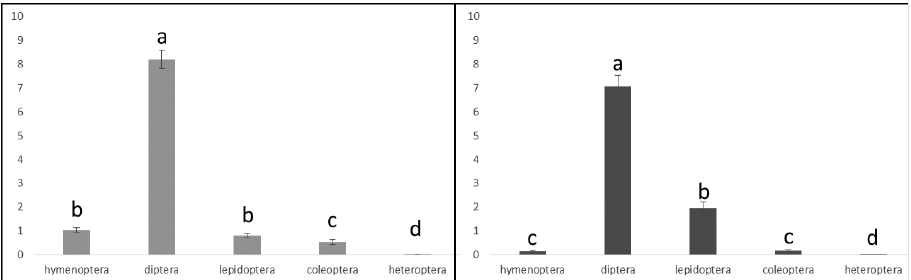
Figure 2. Average number of insects per urns in 2015 (light grey) and 2016 (dark grey). Letters indicate the statistical differences at p=0.005 (Wilcoxon test with Bonferroni